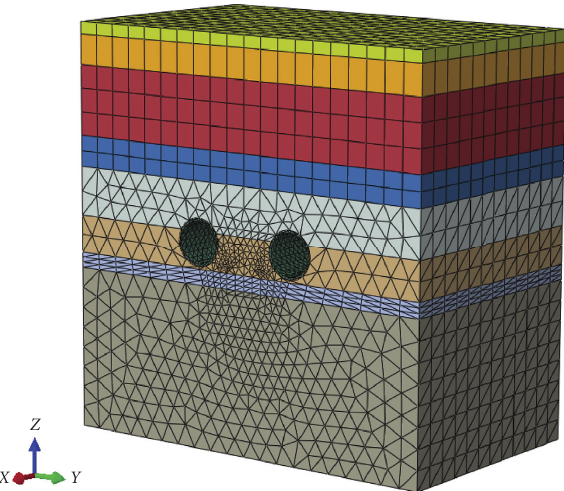
Figure 4: Integral finite-element model of the cross passage.